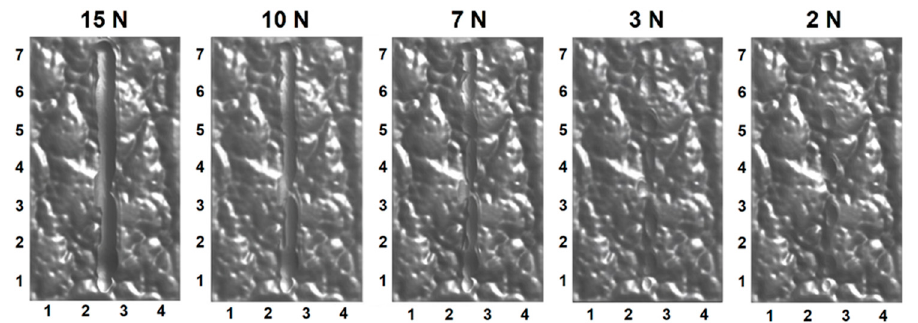
Figure 12. Simulated scratches showing the hidden bruise spots (2 N and 3 N) and continuous material damage (10 N and 15 N) of the CB textured